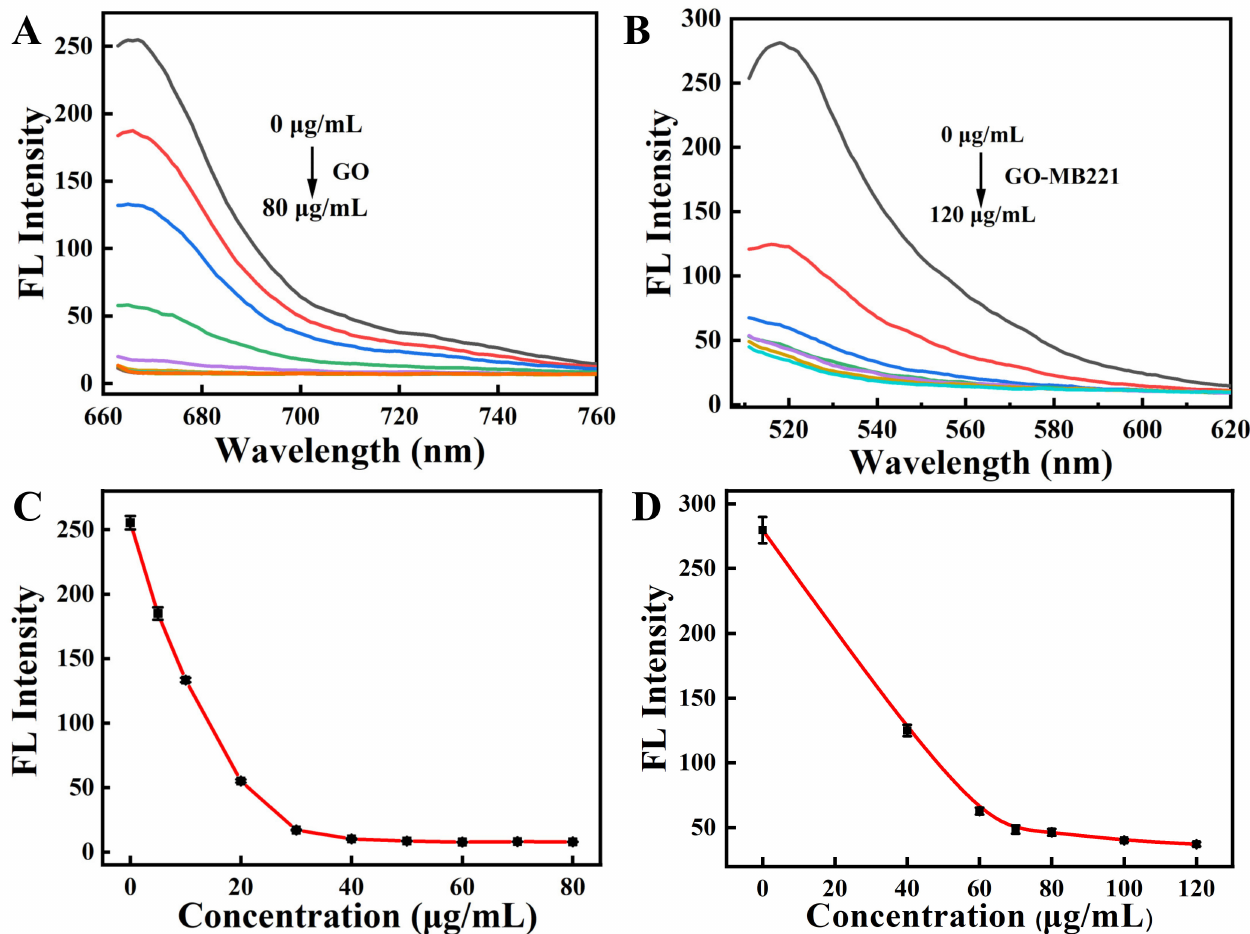
Figure 3. The fluorescence quenching spectra of the Cy5-labeled MB (100 nM) with various concen- trations of GO ( A ) and the FITC-labeled peptide (300 nM) with various concentrations of GO-MB ( B ). Plot of the fluorescence intensity at various concentrations of GO ( C ) and GO-MB ( D ). (Cy5-labeled MB, λ ex/ λ em = 648 nm/667 nm; FITC-labeled peptide, λ ex/ λ em = 480 nm/520